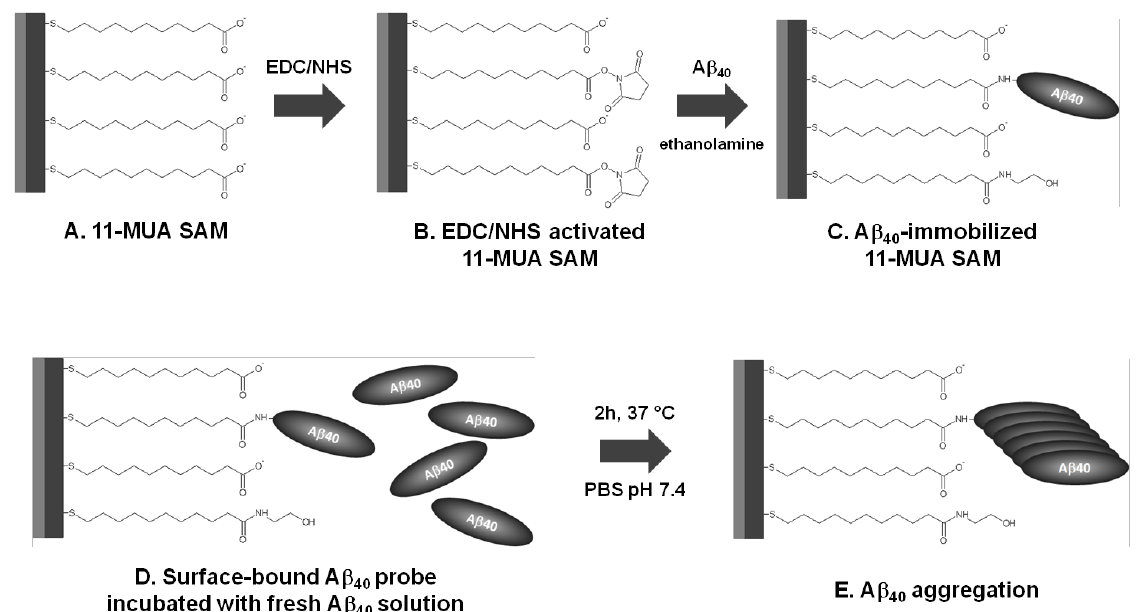
immobilization on 11-MUA-SAM modified gold 40